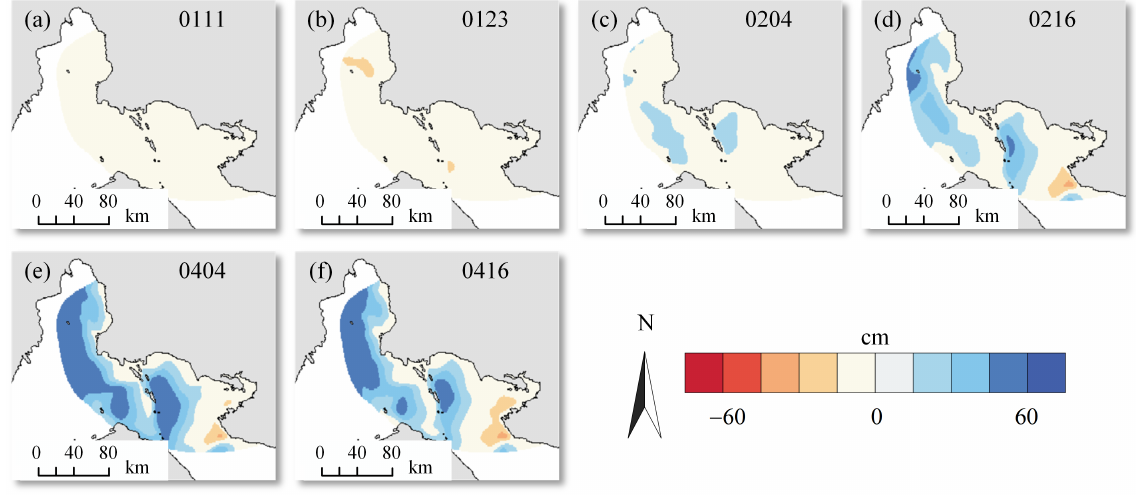
Figure 7. Retrieved time-series horizontal deformation from January 2020 to April 2020: the top-right number of subfigures ( a – f ) represents the corresponding SAR images acquisition